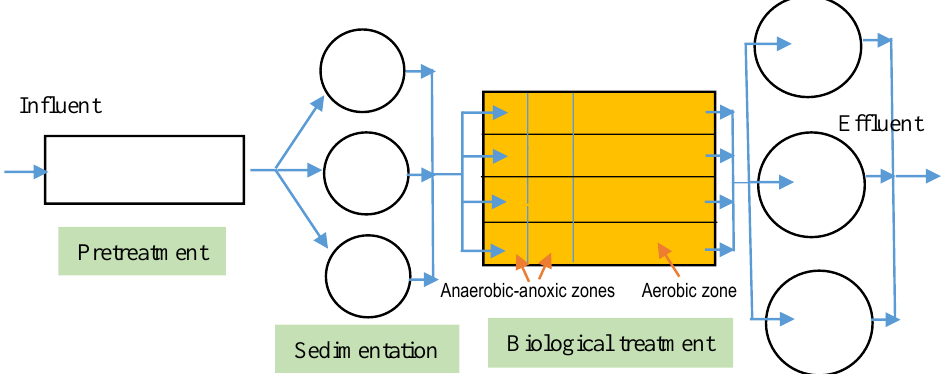
Figure 2. Scheme of the WWTP. Average influent flow rate was 60,466 m 3 /d during the measuring time. Total biological reactor volume (orange colour) was 37,240 m 3 , 4 chambers of 9310 m 3 ( Θ = 14.8 h), and oxygen concentration was maintained in 1.5 ± 0.3 mg/L.